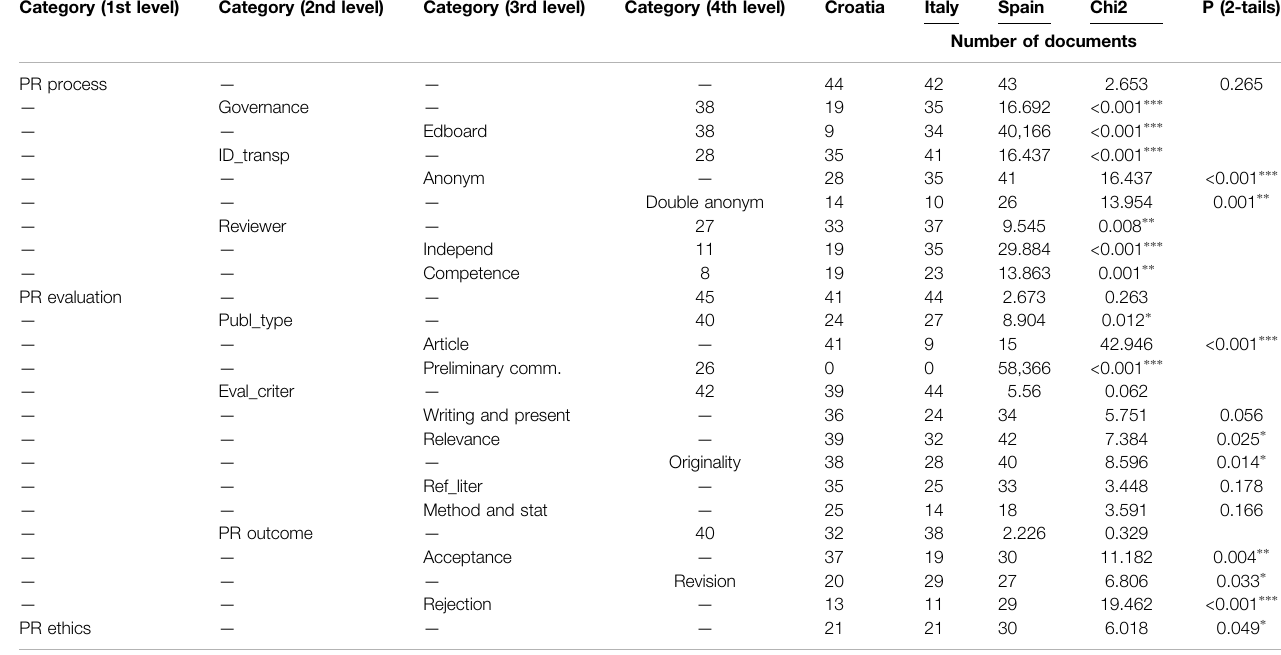
TABLE 6 | Distribution of categories identi fi ed in at least 50% of the documents by country (Croatia 48, Italy 43, Spain